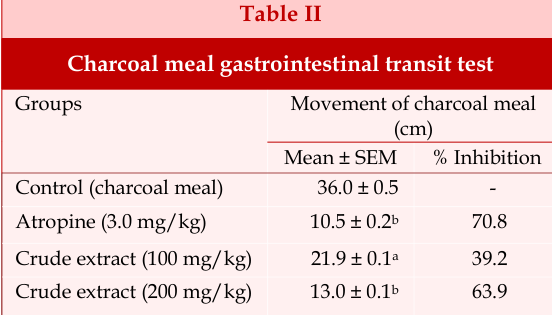
Charcoal meal gastrointestinal transit